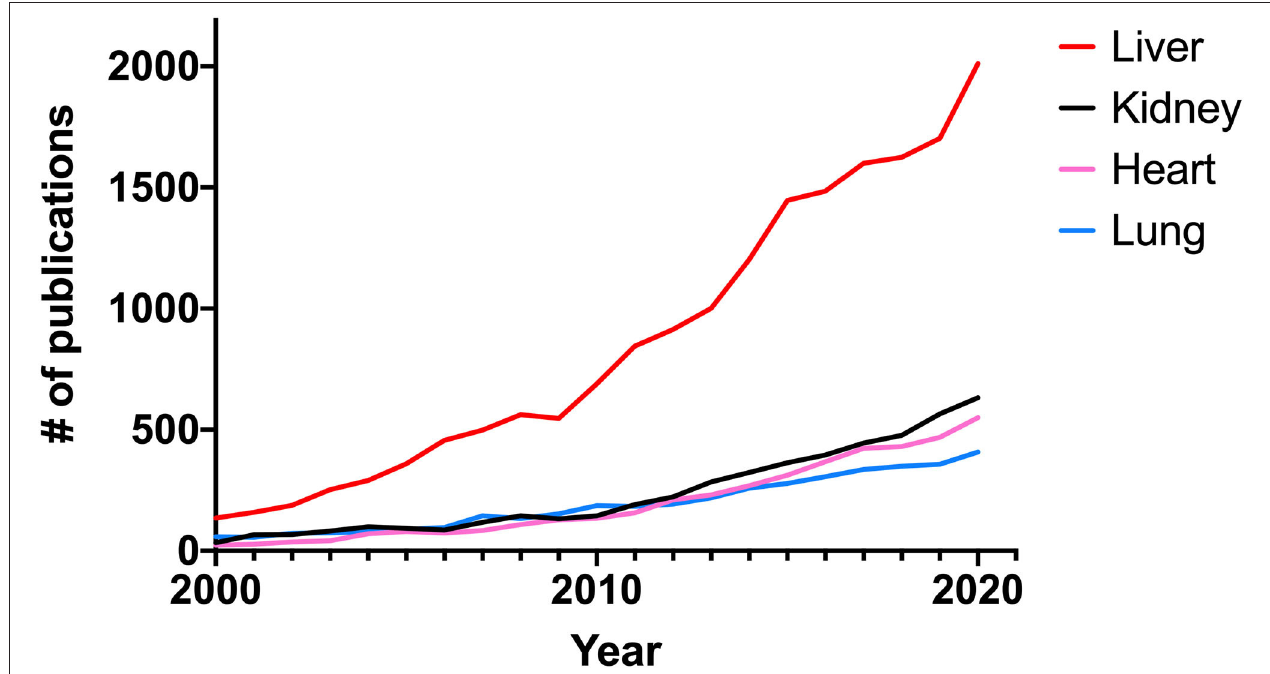
FIGURE 1 | Number of publications related to fibrosis per year indexed in PubMed from 2000 to